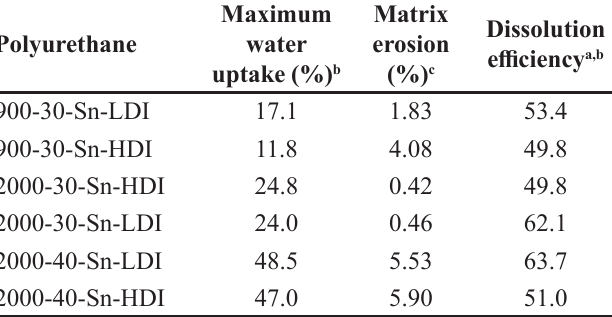
a Defined as the area under the dissolution curve up to 192 h, expressed as a percentage of the area of the rectangle described by 100% dissolution in the same time. b n =3, pooled S.D. = 4.7 (%). c n =3, pooled S.D. = 1.1(%)